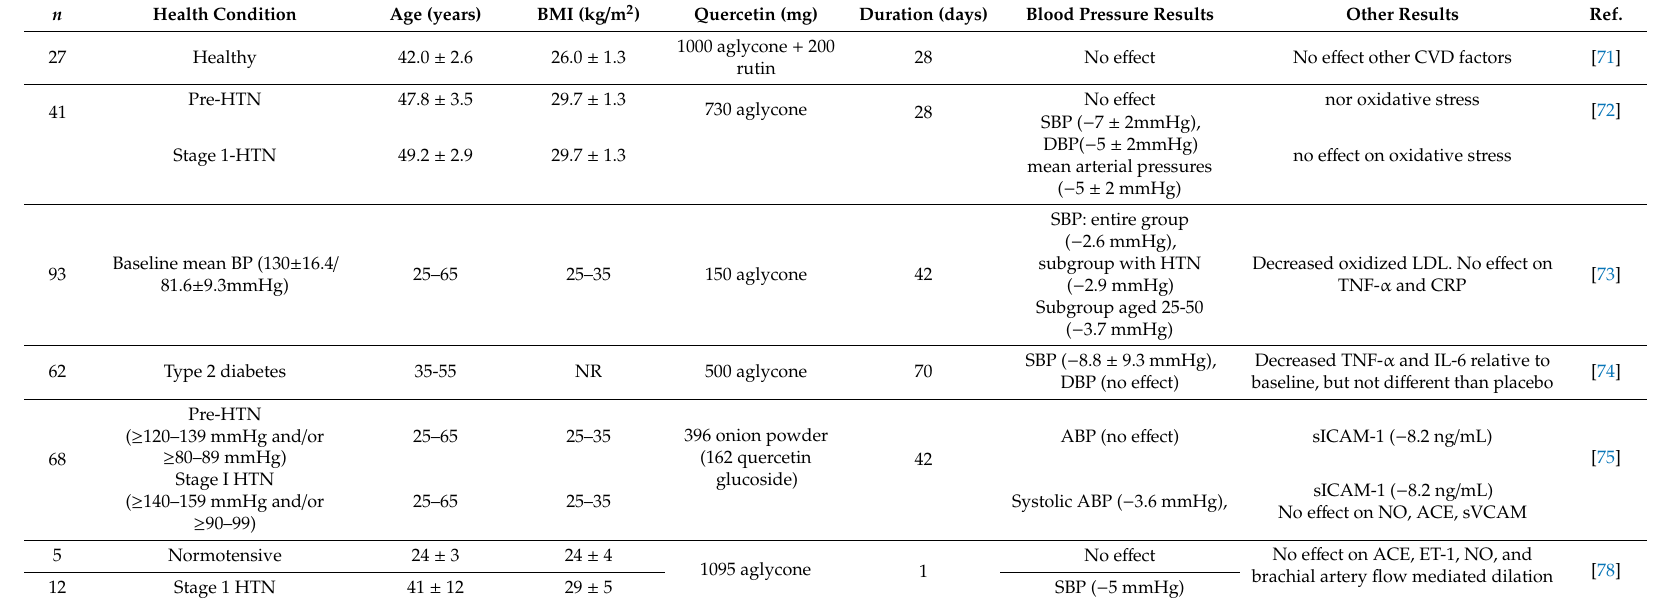
Table 5. Studies on the e ff ectiveness of quercetin on hypertension, inflammation, and cardiovascular